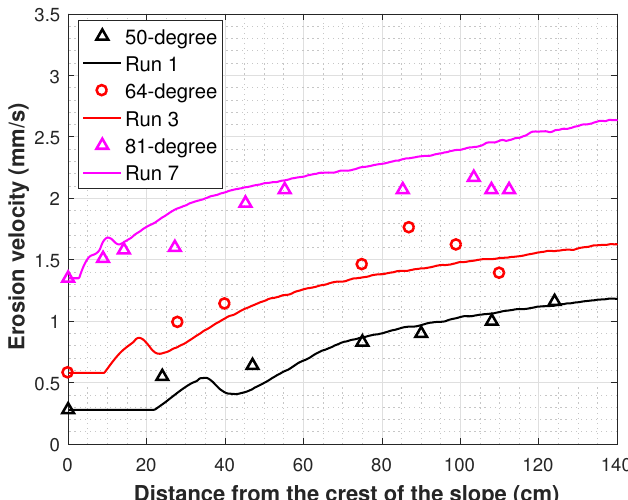
Figure 6. Comparison of erosion velocities resulted from numerical simulations and lab